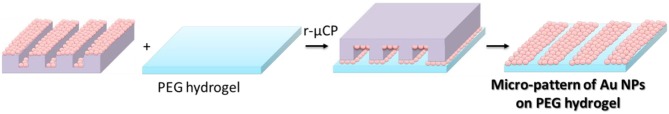
Schematic view of reactive micro-contact printing (r-μCP) process of Au NPs on PEG hydrogels.